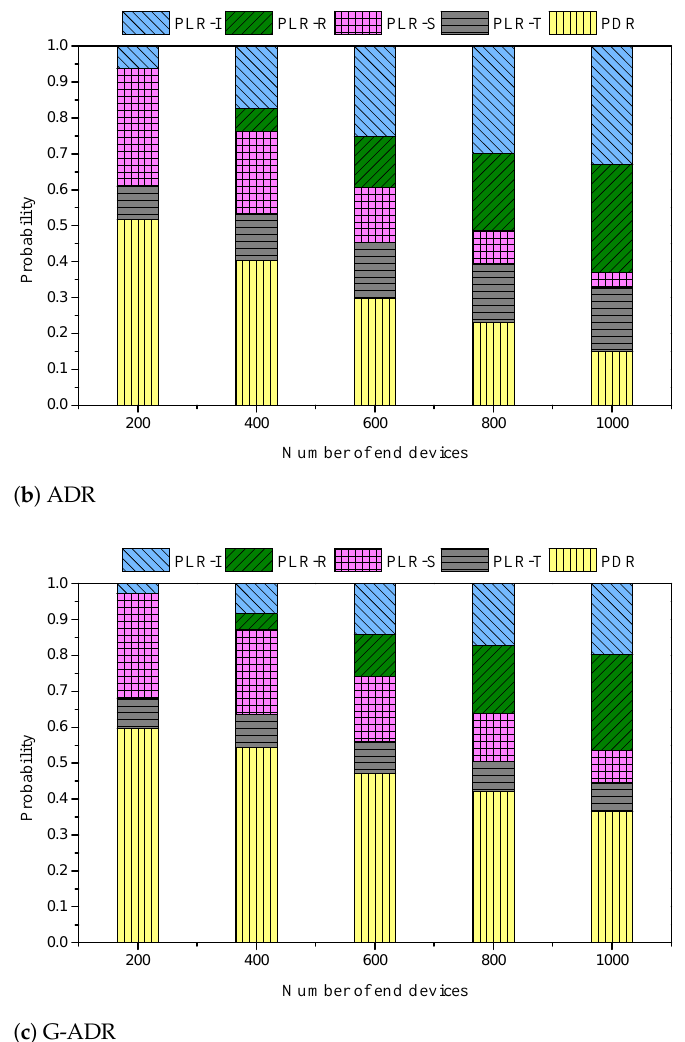
Figure 8. Probability of packet delivery and loss ratios (PDR and PLRs) of the proposed RM-ADR, ADR, and